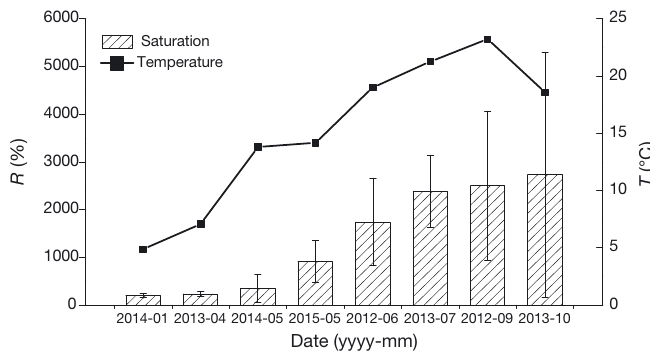
Fig. 7. CH 4 saturation ( R , %; mean ± SD) and water tem- perature ( T , °C) in surface waters of Sanggou Bay